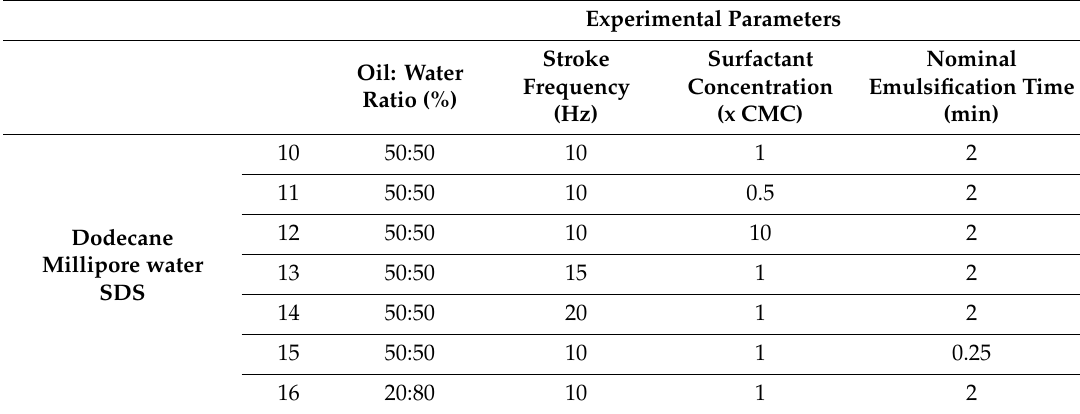
Table 2. Experimental conditions of the experiments with Piston